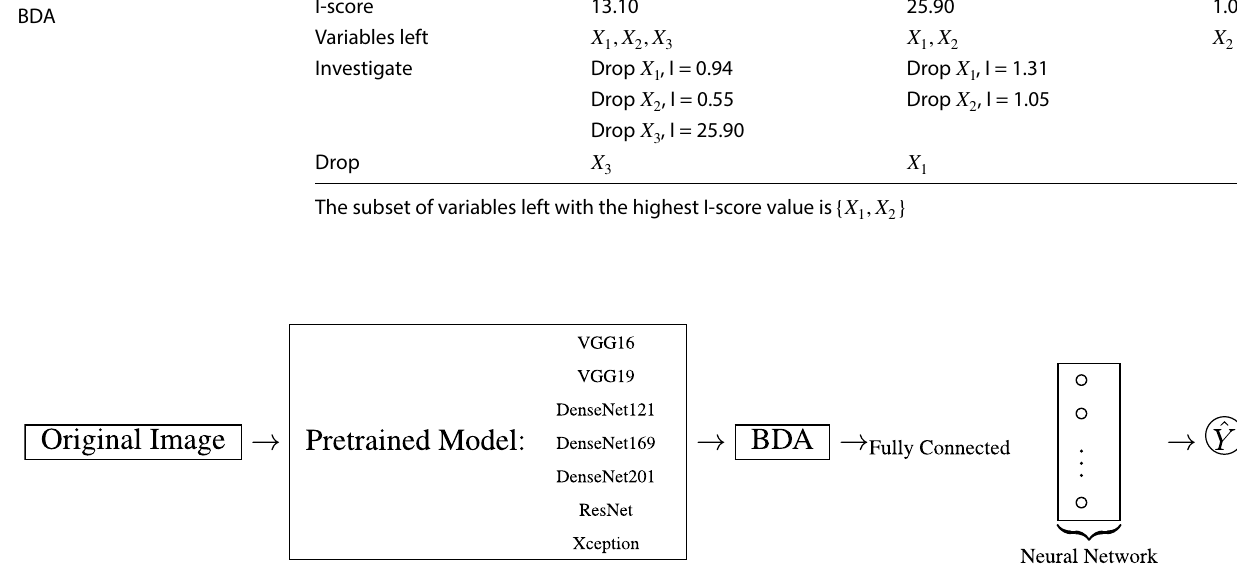
Table 1 Demonstration of BDA